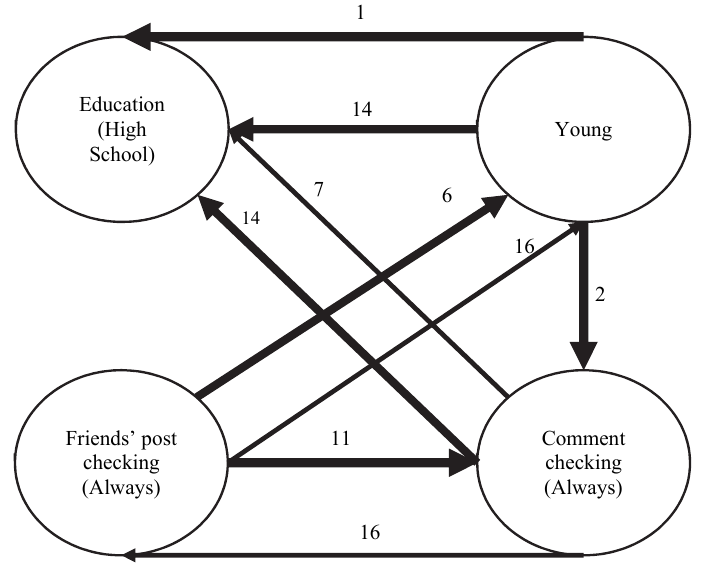
Fig. 2. The obtained sub-graph by the KM